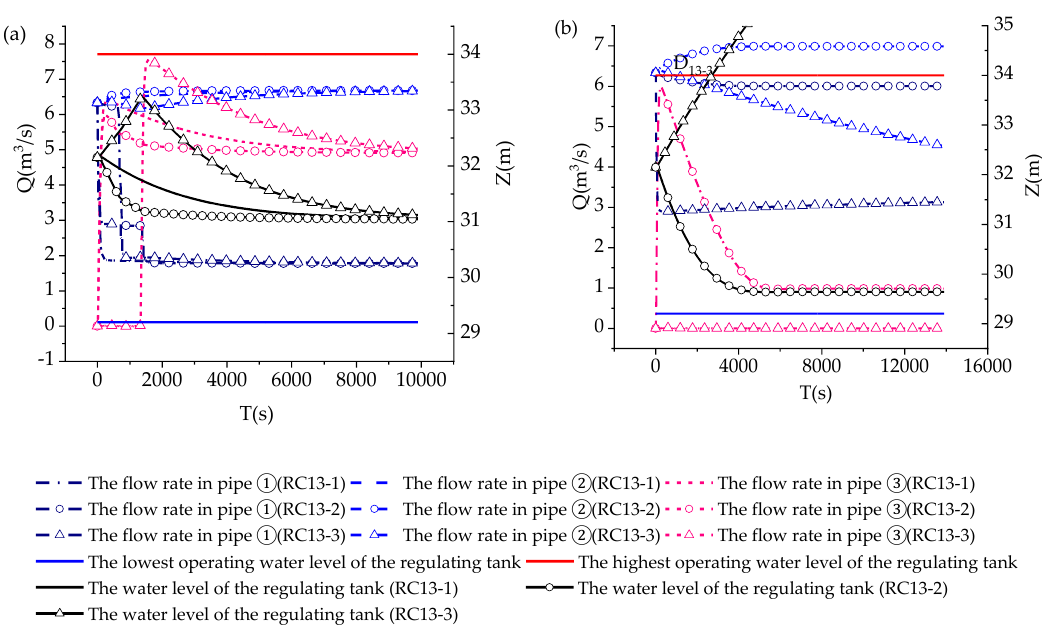
Figure 9. ( a ) Transient from scenario OS1 to scenario OS3; ( b ) the maximum allowable time interval between the coupled control of pumps and valves.